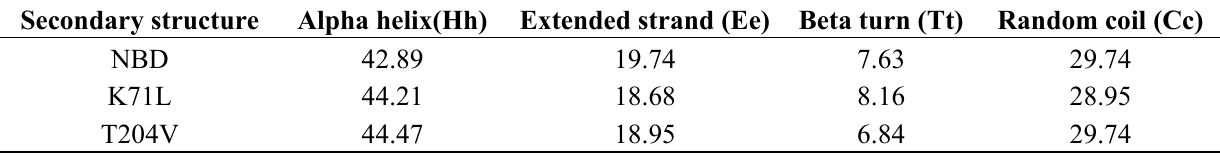
Table 2. Secondary structures of the NBD protein, K71L and T204V mutants. Secondary